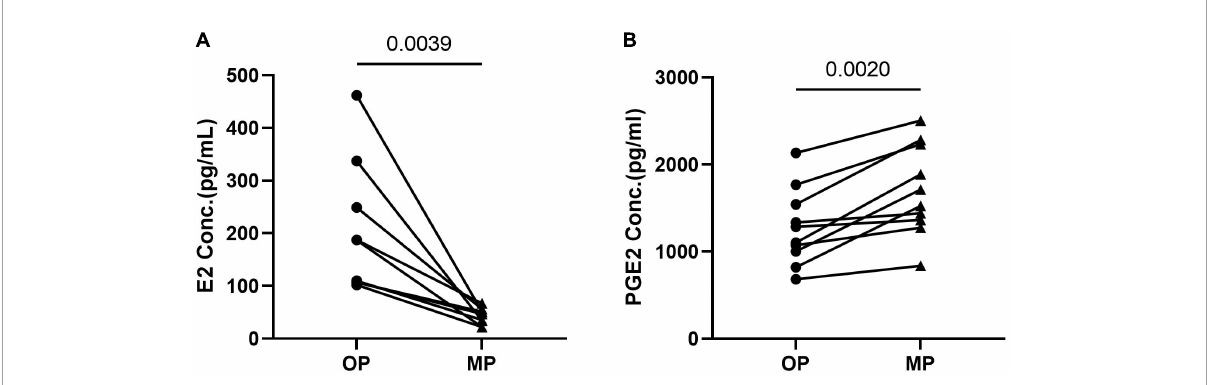
FIGURE1 The expression of estradiol (E2) and prostaglandin estradiol (PGE2). (A) E2 expression decreased in menstrual period (MP) when compared with ovulation period (OP). N = 9. (B) PGE2 increased in MP compared with OP. N = 10. Significance determined by paired t -test p < 0.05. The • represents OP and the (cid:78) represents